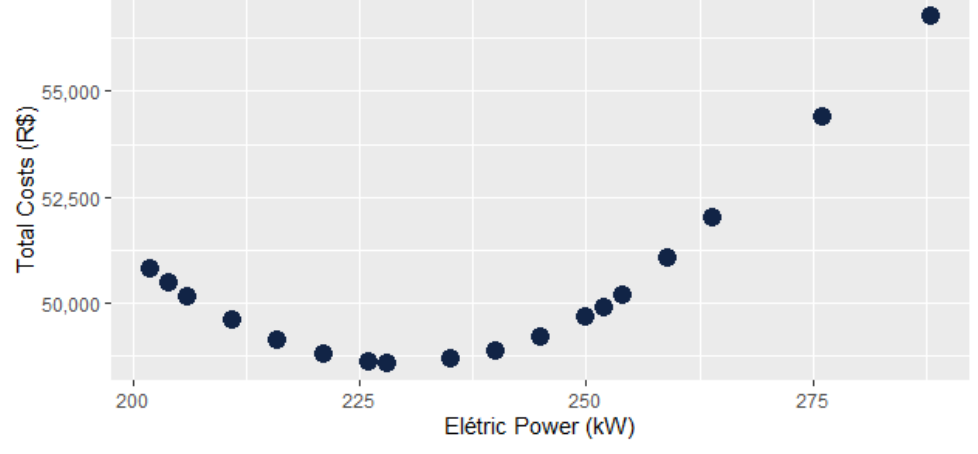
Figure 4. Power demand costs.